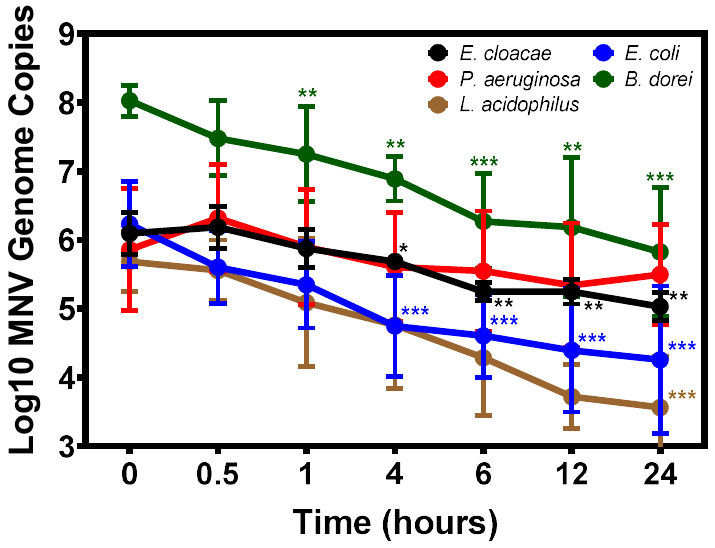
Figure 3. Temporal binding of MNV to commensal bacteria. MNV-1 was inoculated into diluted bacterial cultures, incubated at 37 °C and sampled at the indicated time points. Virus concentrations were determined using RT-qPCR. MNV-1 genomes were detected immediately (0 h) in all bacterial cultures and significantly decreased over 24 h for all bacteria (* = p ≤0.05, ** = p ≤0.01, *** = p ≤ 0.001)except P. aeruginosa ( n = 3). Significance over time was determined using one-way ANOVA and differences at given time points between specific samples were analyzed using unpaired Students t test, both in GraphPad Prism.